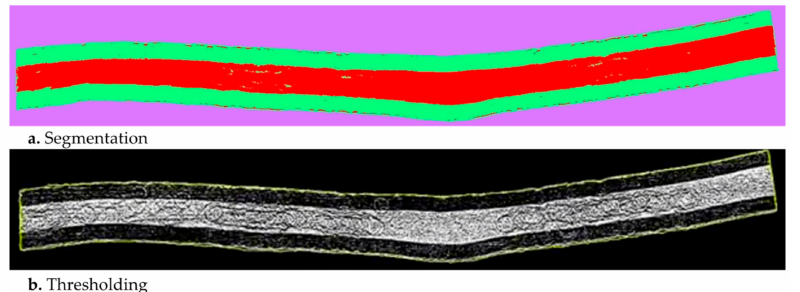
Figure 8. Image processing of the CT images: ( a ) region segmentation with Image J of prepreg sample representative slice for the (purple) background, (green) resin, and (red) fiber and ( b ) region of interest adapted for each slice of the prepreg sample (highlighted as yellow